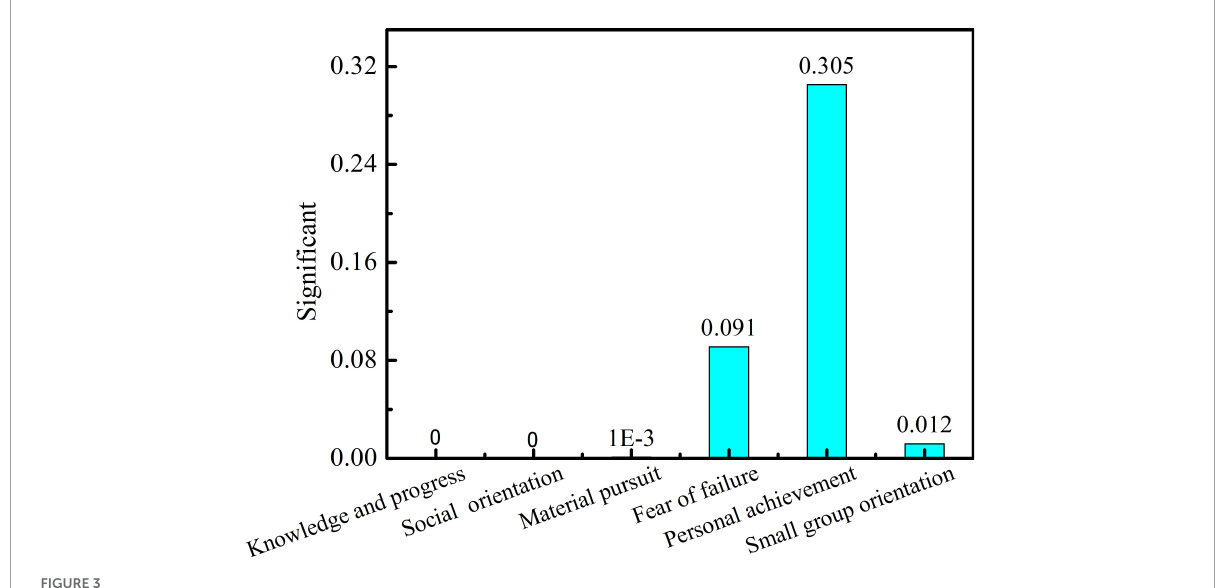
FIGURE3 Significance of students’ learning motivation in college of metallurgical engineering, college of mechanical and electrical engineering, and college of art. Table 2 significance of learning motivation in gender, region, and only child or